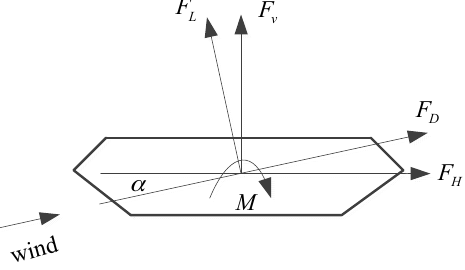
Figure 3. Definitions of aerodynamic force coefficients: drag, lift and moment force.